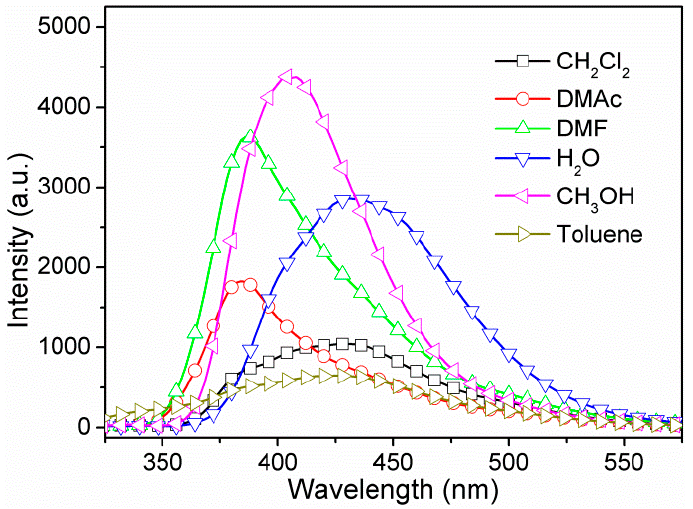
Figure 3. Fluorescence emission spectra of 1 in suspension-phase of different solvents.